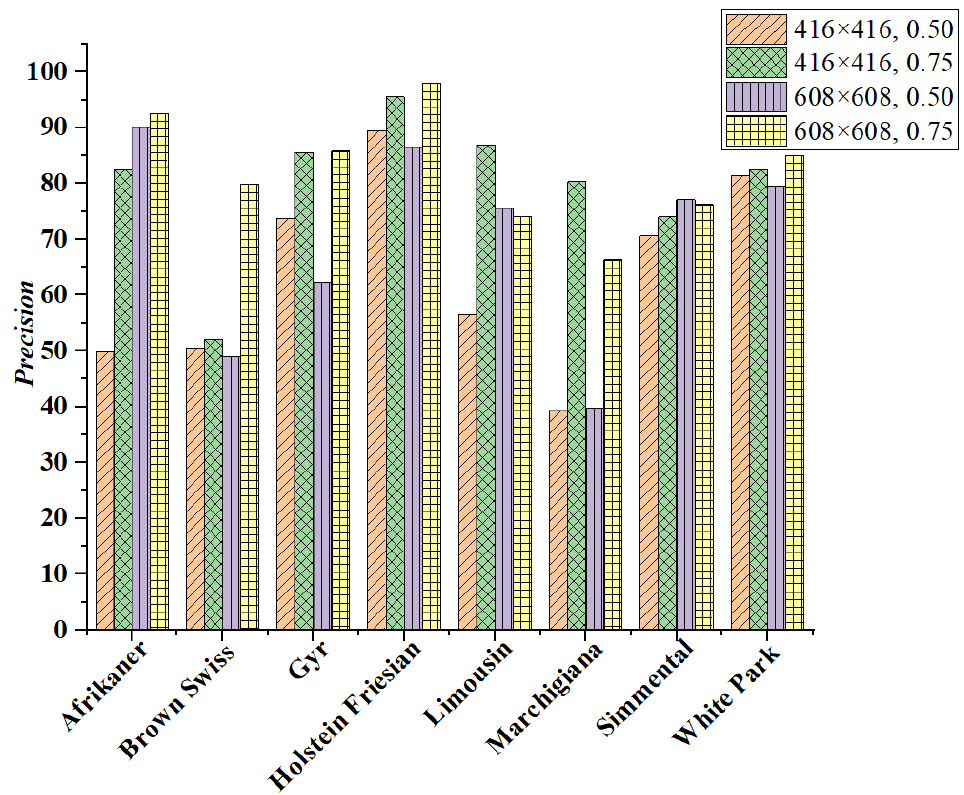
Figure 17. Class-wise precision.